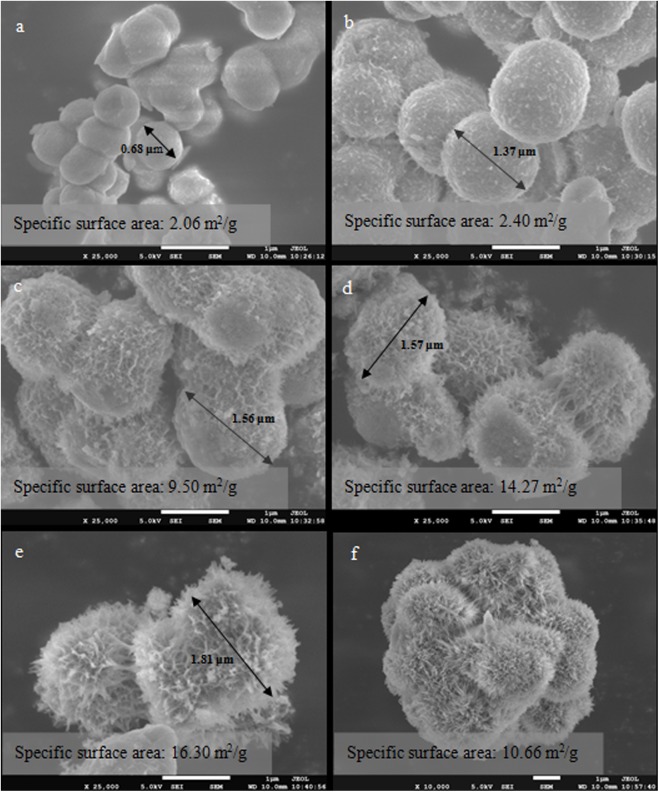
Scanning electron microscopy images and specific surface area of precipitates harvested from different schwertmannite synthesis systems.150 mL of FeSO4·7H2O solution with addition of a: 1.80 mL of H2O2 at 2 h (treatment 1); b: 0.90 mL of H2O2 at 2 and 14 h (treatment 2); c: 0.60 mL of H2O2 at 2, 14, and 26 h (treatment 3); d: 0.45 mL of H2O2 at 2, 14, 26, and 38 h (treatment 4); e: 0.36 mL of H2O2 at 2, 14, 26, 38, and 50 h (treatment 5); and f: Acidithiobacillus ferrooxidans; volume concentration of H2O2: 30%; molar concentration of FeSO4·7H2O: 160 mmol/L